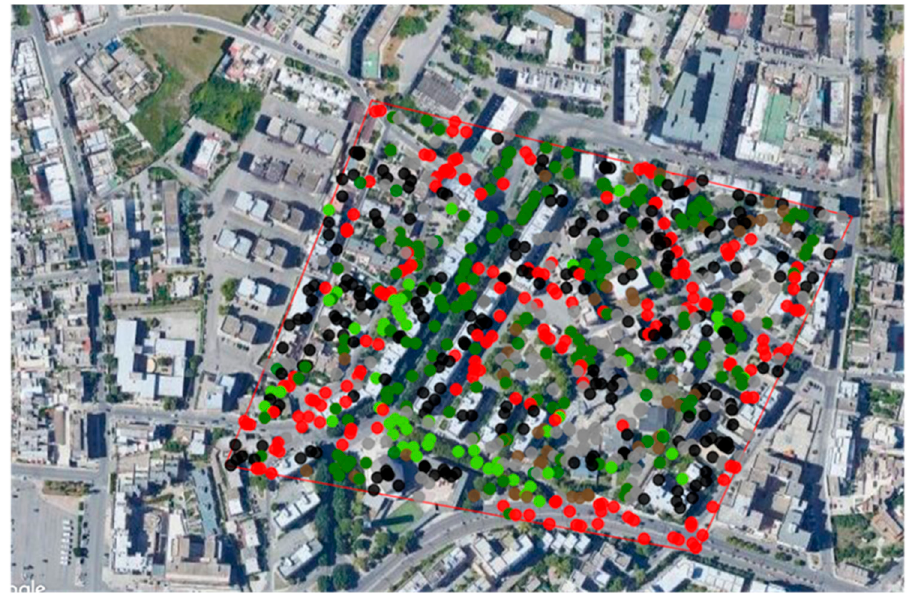
Figure 2. The 847 randomly sampled points within the study area considered in i-Tree Canopy.